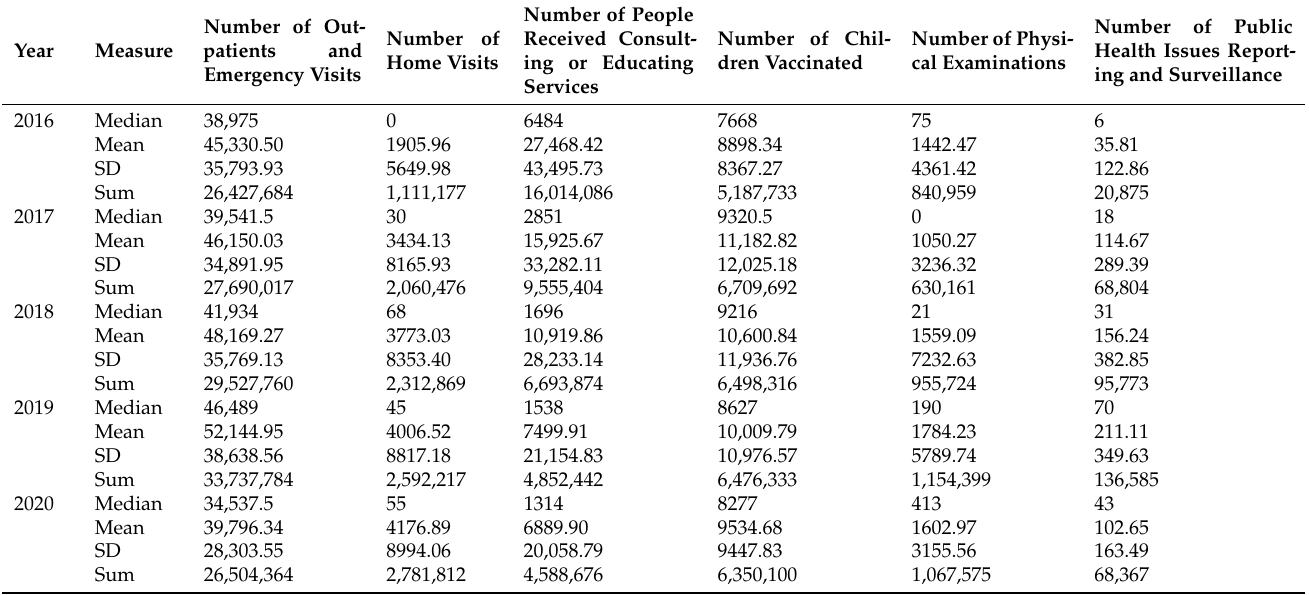
Table 3. Descriptive statistics of outputs of the DEA